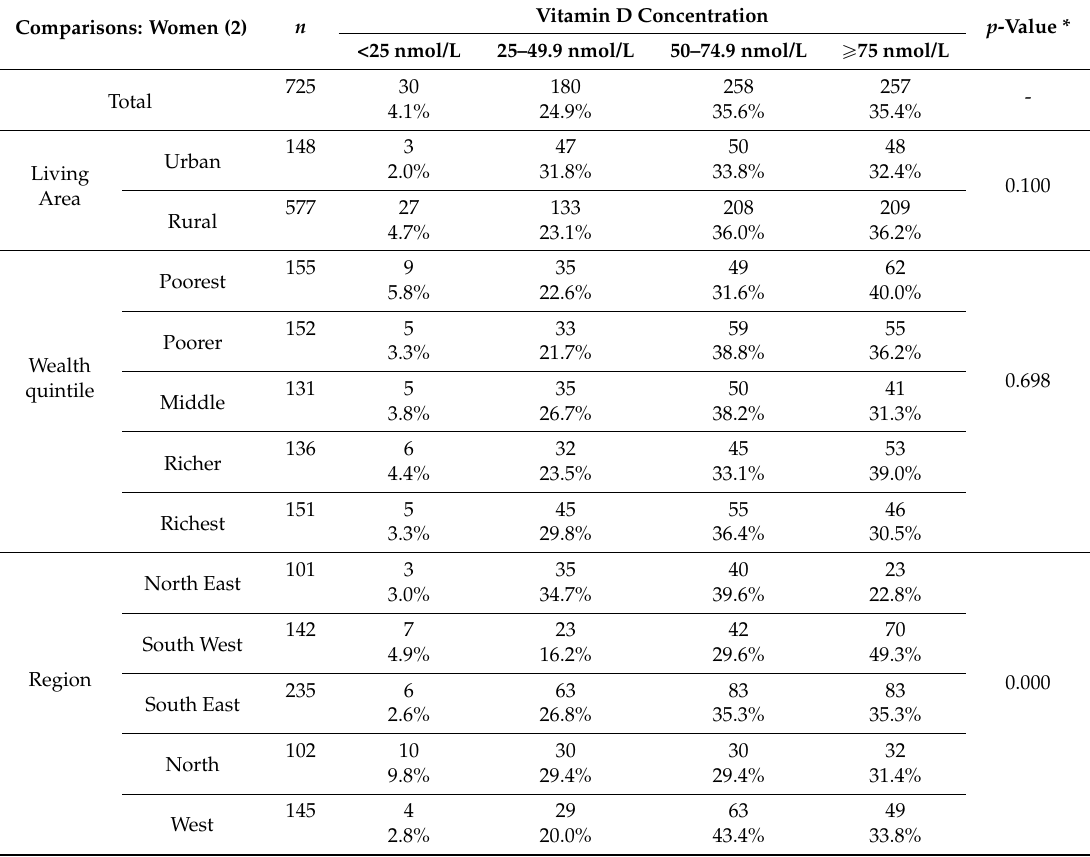
Table 2. Comparison of relationships between the vitamin D status and living area, region, and wealth grouping among